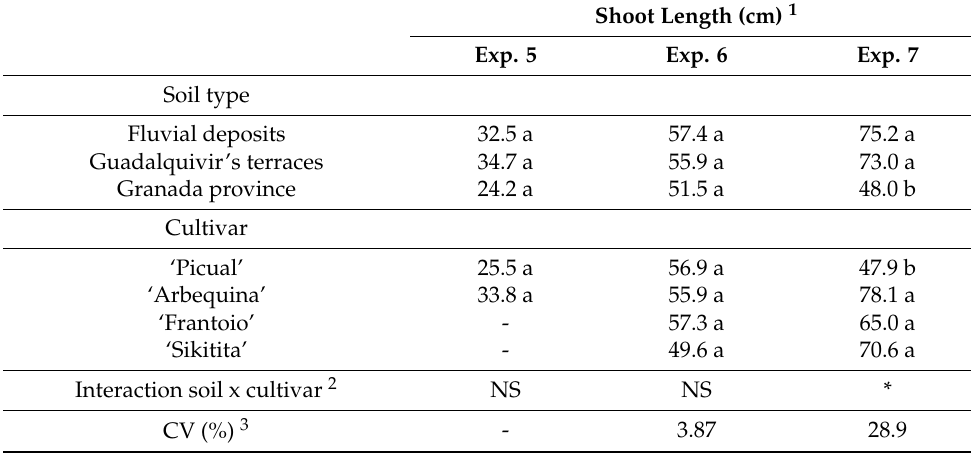
Table 5. Vegetative growth of olive cultivars growing in different